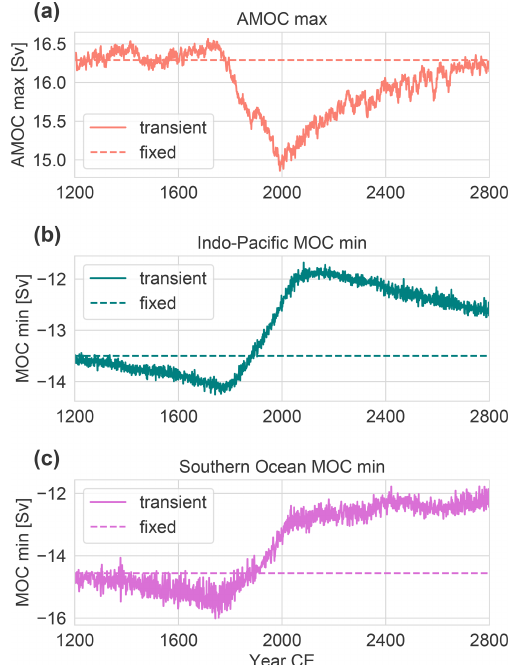
Figure 2. Response of the maximum and minimum values of the meridional overturning circulation (MOC) to imposed SST, SSS and sea ice (Fig. 1b). (a) Atlantic MOC maximum, (b) minimum of the MOC in the combined Pacific and Indian basins (IPMOC) and (c) in the Southern Ocean (SOMOC). Simulations OcTRA (tran- sient) and OcFIX (fixed) are